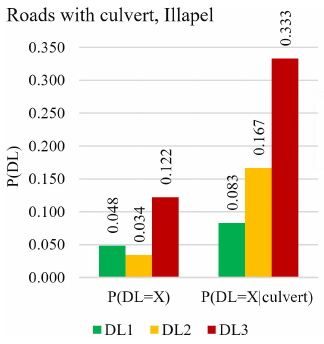
Figure 15. Total road damage probability and increased total road damage probability with the presence of a culvert.